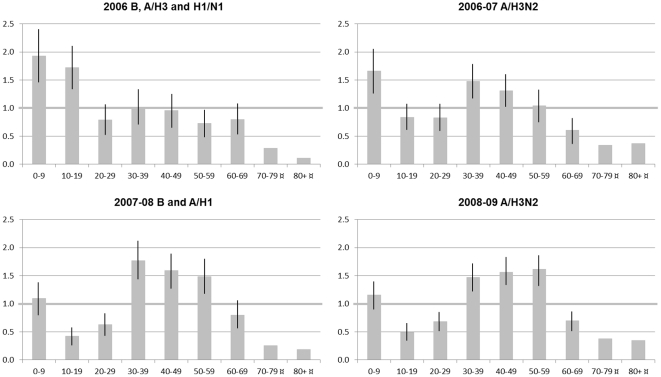
RIR diagrams for seasonal influenza outbreaks in Östergötland county 2006–2009.